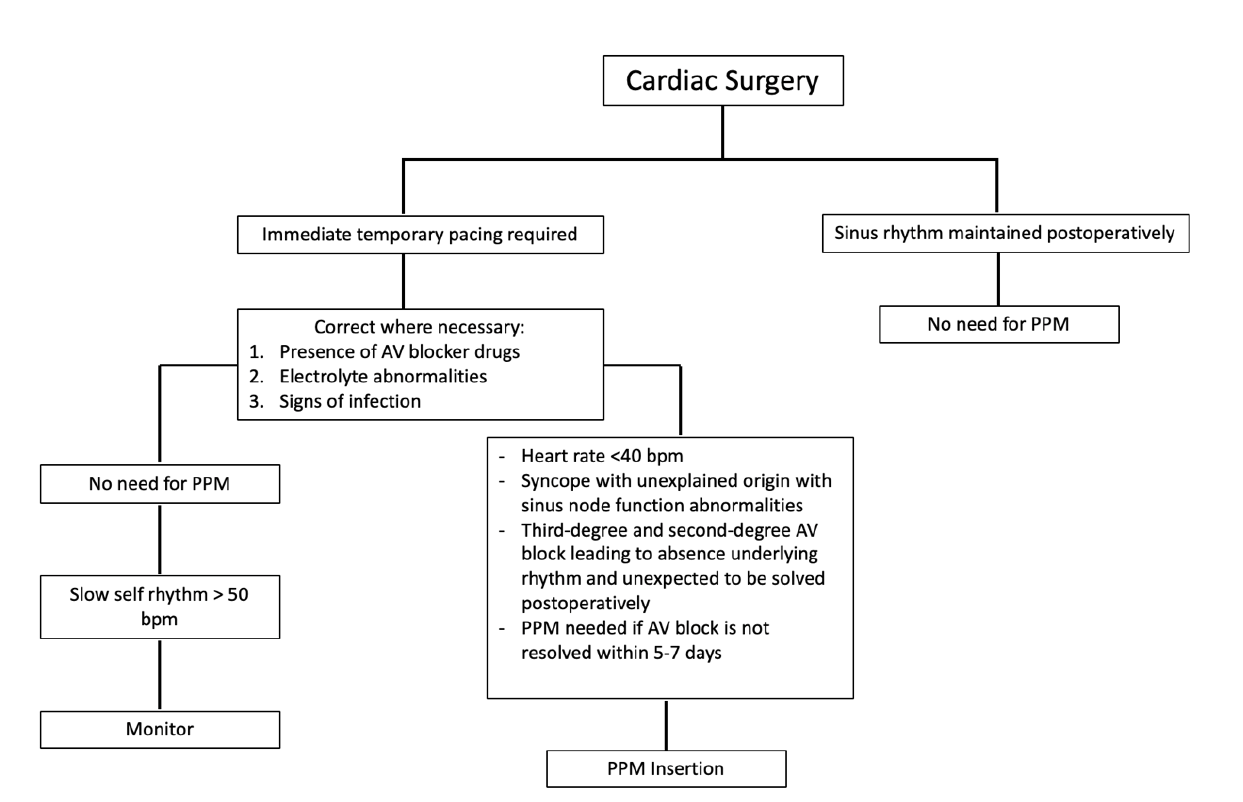
Fig. 1 – Flow chart of how permanent pacemaker (PPM) is indicated post cardiac surgery. [32,41] AV=atrioventricular; bpm=beats per minute